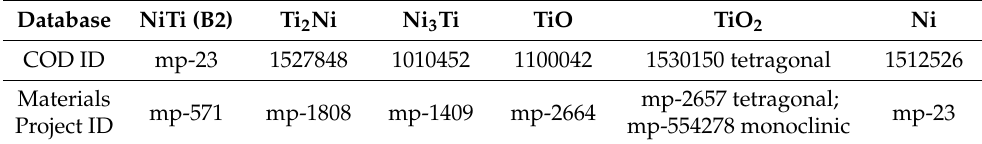
Figure 2. XRD diffractograms of the porous NiTi samples. Table 1. COD and Materials Project IDs of the identified phases.